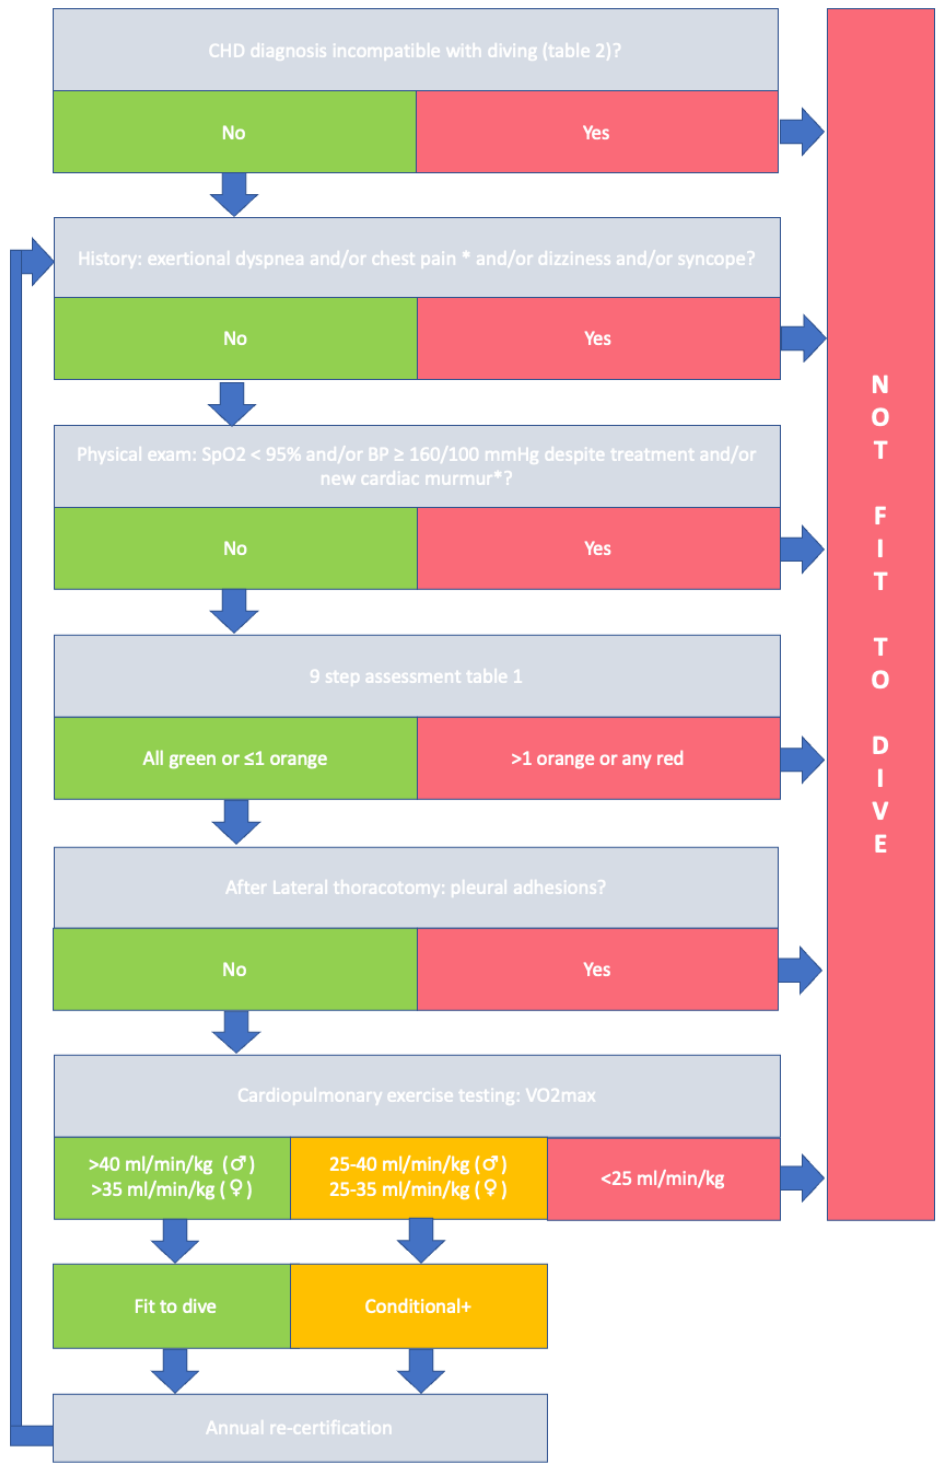
Figure 1. Evaluating fitness-to-dive in ACHD patients. * Reassessment after clinical work-up. + Conditional, non-strenuous diving